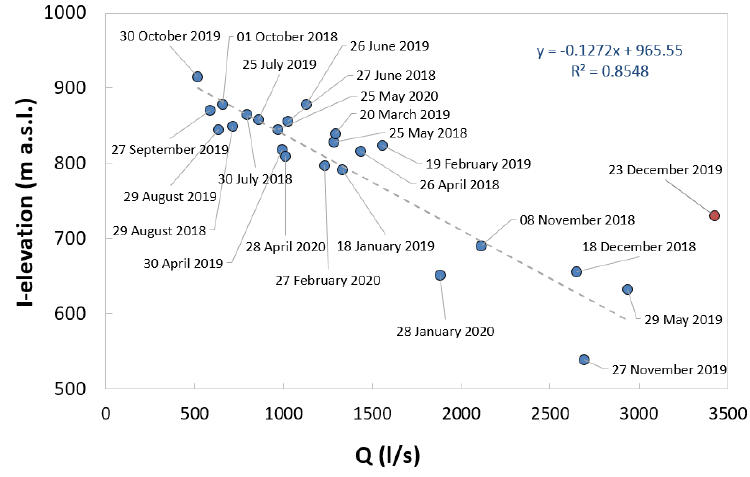
Figure 10. Update of the linear relationship proposed in the previous paper [21]: discharges supplied by Capodacqua di Spigno Spring in relation to average recharge area elevations.